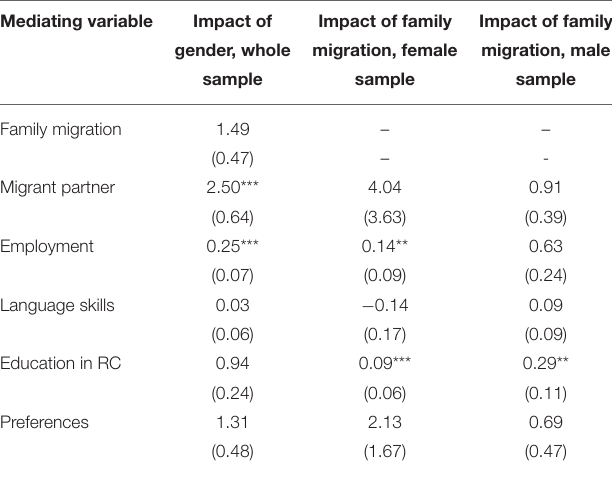
TABLE 5 | Impact of gender (whole sample) and family migration (women and men separately) on mediating variables.